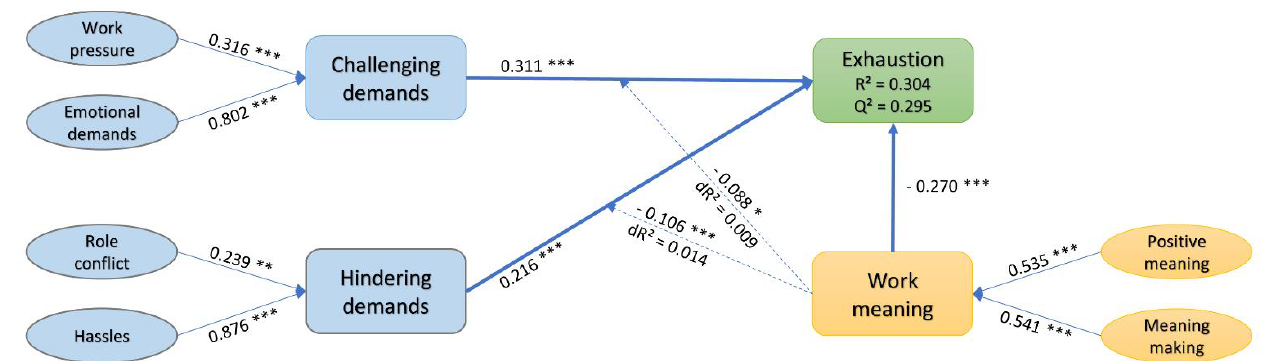
Figure 2. Results of the research model. Path estimates were significant (* ρ < 0.05, ** ρ < 0.01, *** ρ < 0.001) and reported as standardized.